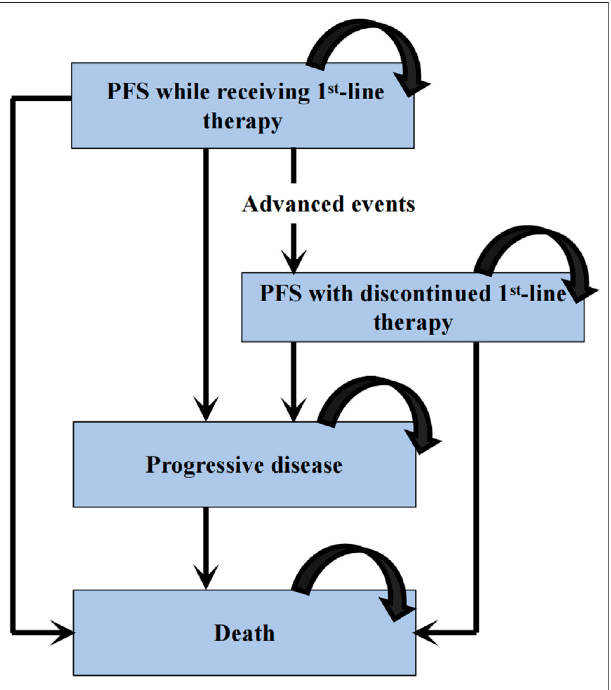
FIGURE 1 | Diagram of the Markov Model. PFS, progression-free